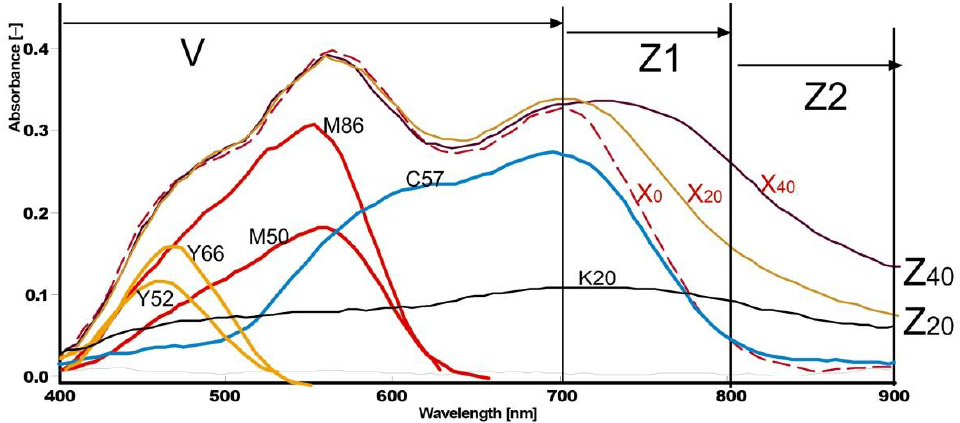
Figure 5. Spectrograms of red color twins (12–Red 2).